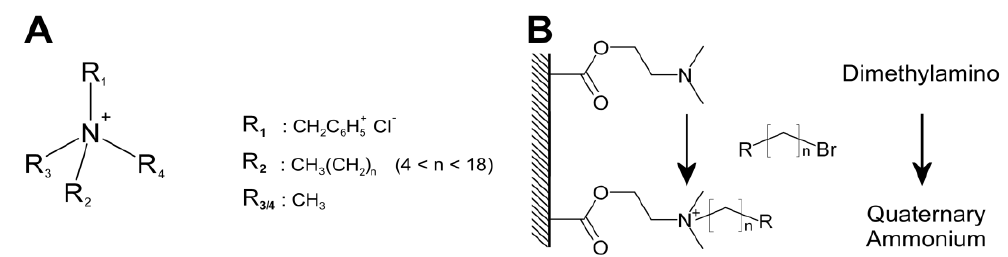
Figure 3. Quaternary ammonium compounds (QACs): Soluble forms of the QACs include benzalkonium chloride (A) . The compound only has antimicrobial activity if the alkyl chain (R ) contains between 4 and 18 (stearalkonium) carbon atoms. (B) Polymers 2 containing tertiary amino groups, like poly-(dimethylaminoethyl methacrylate), can for instance be quaternized by specific functional